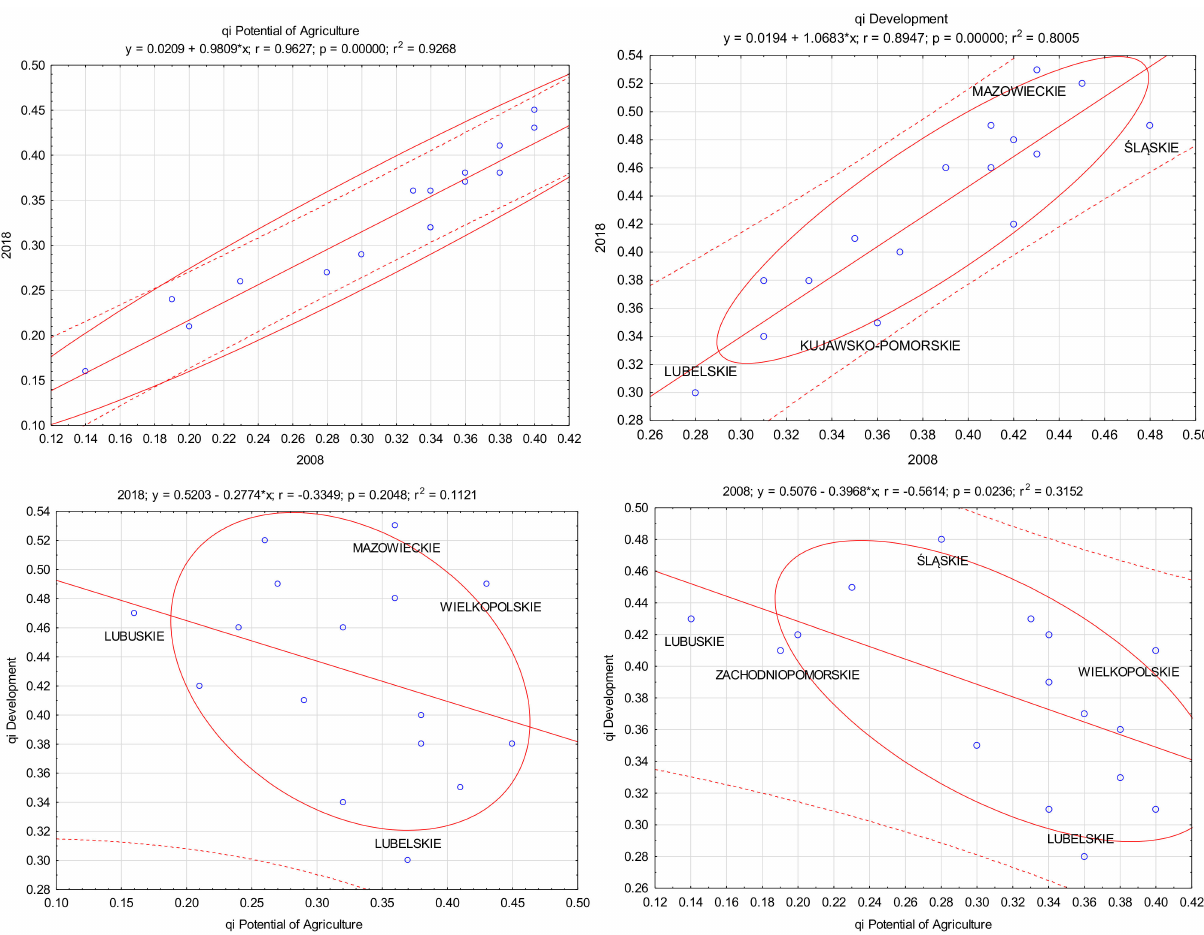
Figure 2. Dispersion of the synthetic measure of development and agricultural potential of voivodships in Poland in 2008 and 2018. Source: own study based on BDL CSO data using the Statistica program